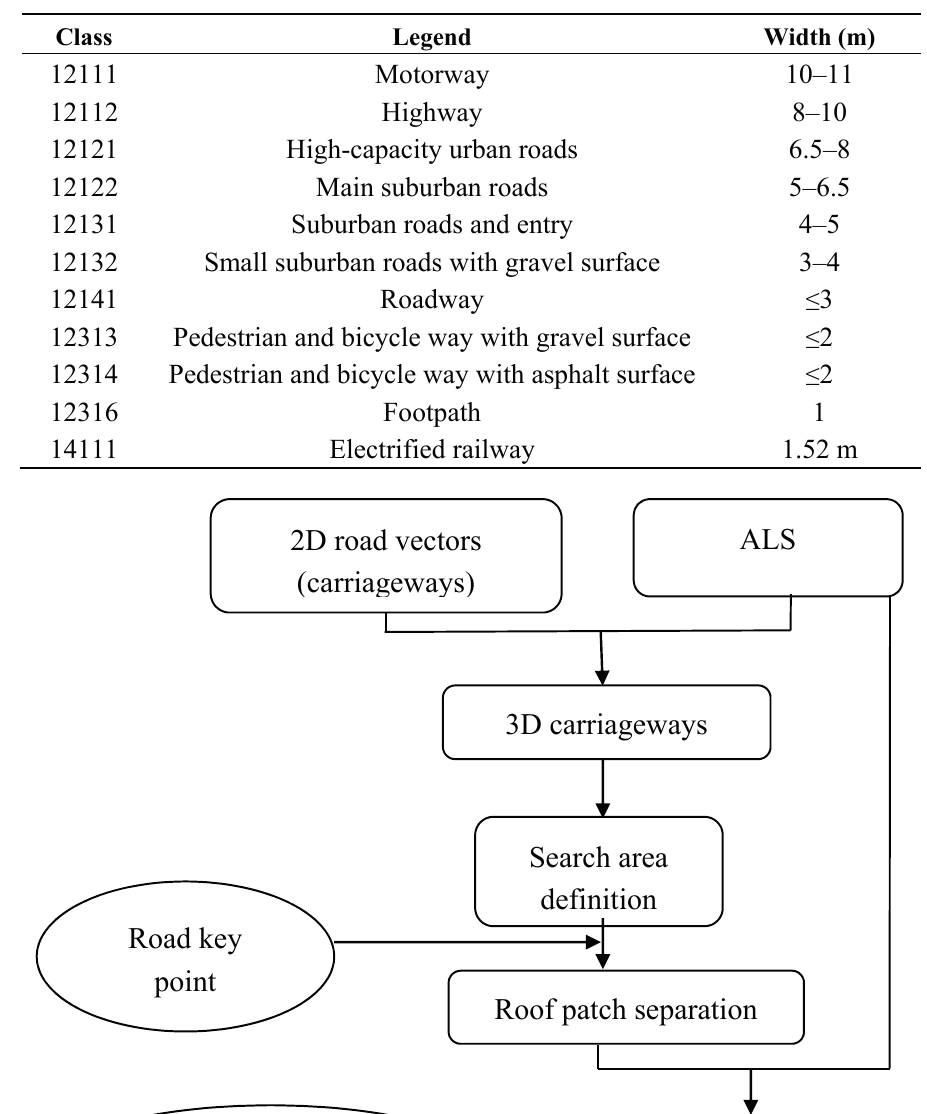
Table 2. Transportation data (the width of a carriageway) from the NLS topographic database.